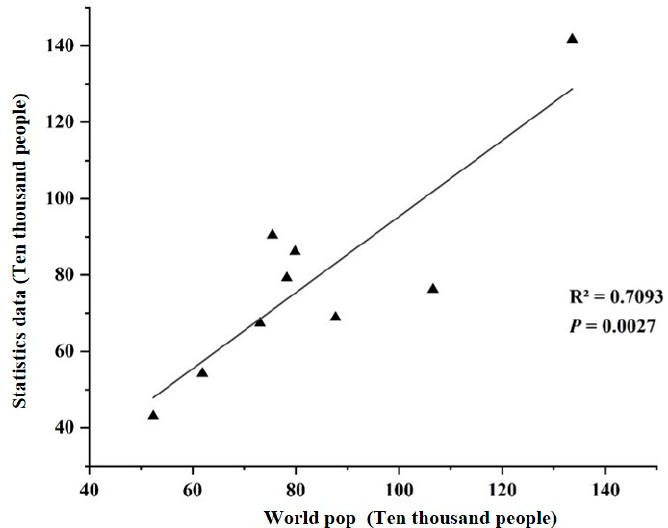
Figure 5. Accuracy verification of population density data.